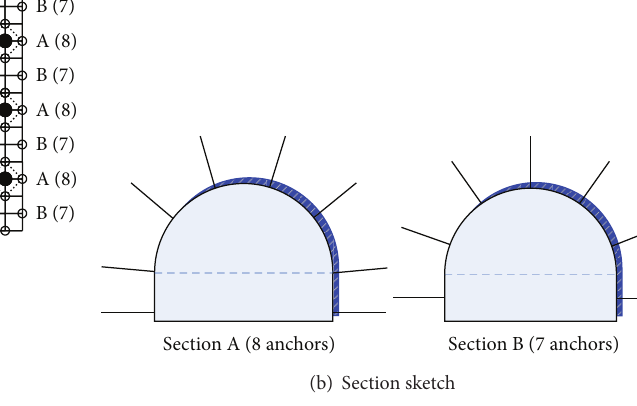
Figure 11: Layout sketch of the equivalent